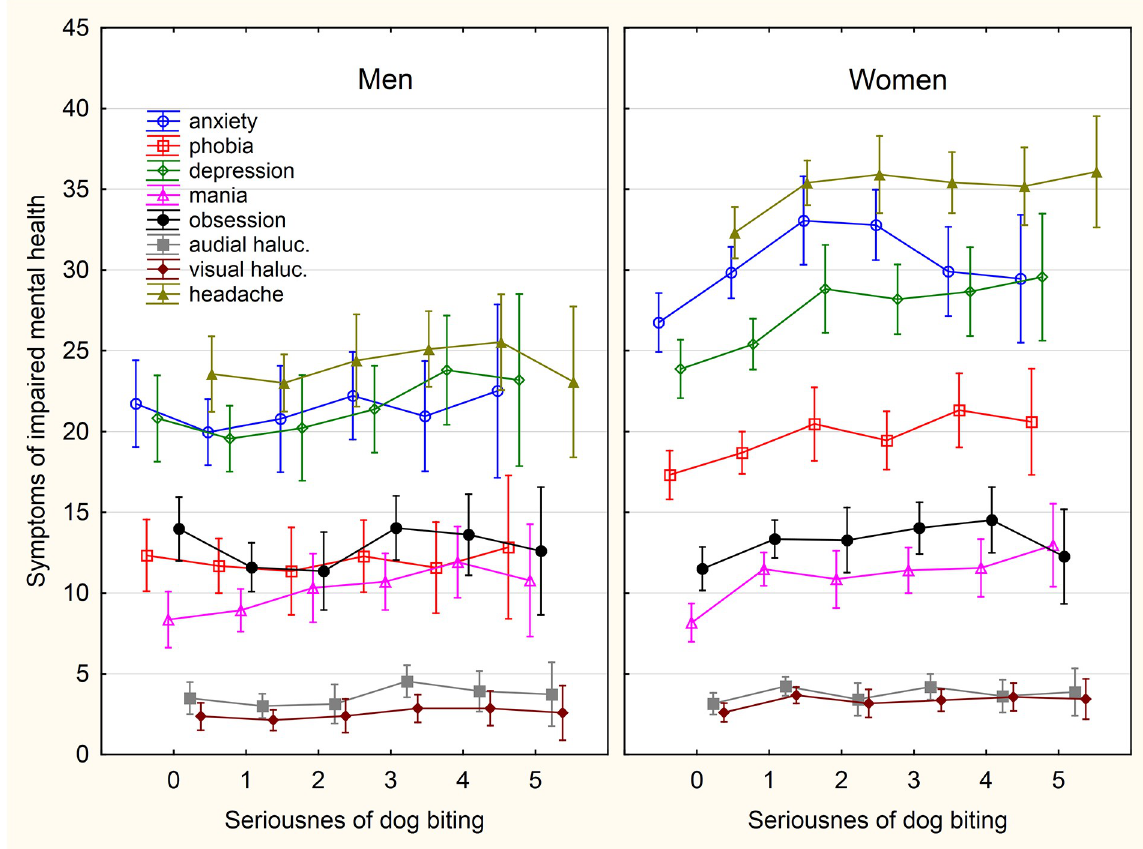
Fig 7. Association between intensity of sustained dog biting and symptoms of impaired mental health. The categories on x-axis describing the intensity of being injured by a pet are: 0- never, 1- only while playing, 2- only as a warning, 3- yes, minor injury (only skin cut), 4- yes, moderate injury (bleeding), 5- yes, serious injury, I had to seek medical